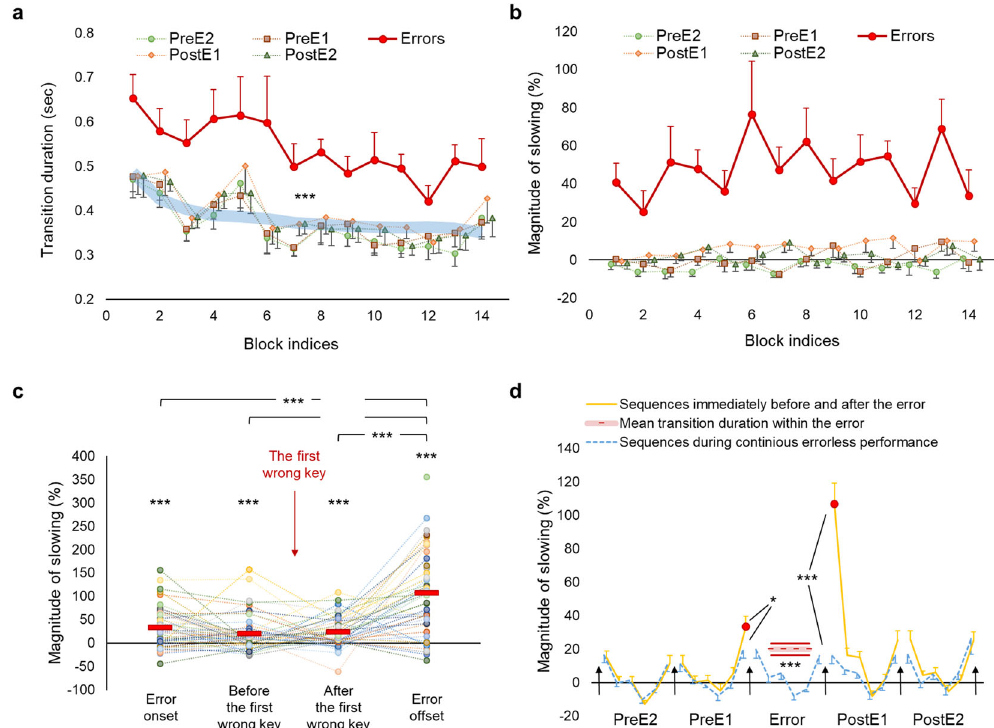
Fig. 3 Behavioral results. a , b Mean time to complete a single transition (i.e., transition duration) and the magnitude of slowing during errors (red markers), and within two adjacent sequences immediately before and after the error (colored markers) are plotted for each performance block. The wide light-blue line marks mean transition durations of all correct trials in each block. Data points represent group means for each block. c The magnitude of slowing at the error onset, within the error — mean values for transitions before and after the fi rst wrong keypress are shown separately — and at the error offset. Data points represent mean values calculated across errors for each individual. Red markers indicate group means. d The magnitude of slowing during periods with and without errors. Orange/blue lines connect mean values for transitions within and between correct trials during these periods. Black arrows indicate transitions between trials. Red circles represent mean values for transitions at the error onset/offset. Dashed and continuous red lines represent the mean magnitude of slowing and standard error of the mean (SEM) within the error, respectively. Zero values of the magnitude of slowing (i.e., the reference line marked by the x -axis) represent the mean transition duration within all correct trials; these values were initially calculated separately for each block, and then used to estimate the magnitude of slowing on a block-by-block basis. PreE2 and PreE1 — two consecutive sequences immediately before the error, PostE1 and PostE2 — two consecutive sequences immediately after the error. * and *** - signi fi cant results at 0.05 and 0.001 level, respectively. Error bars represent